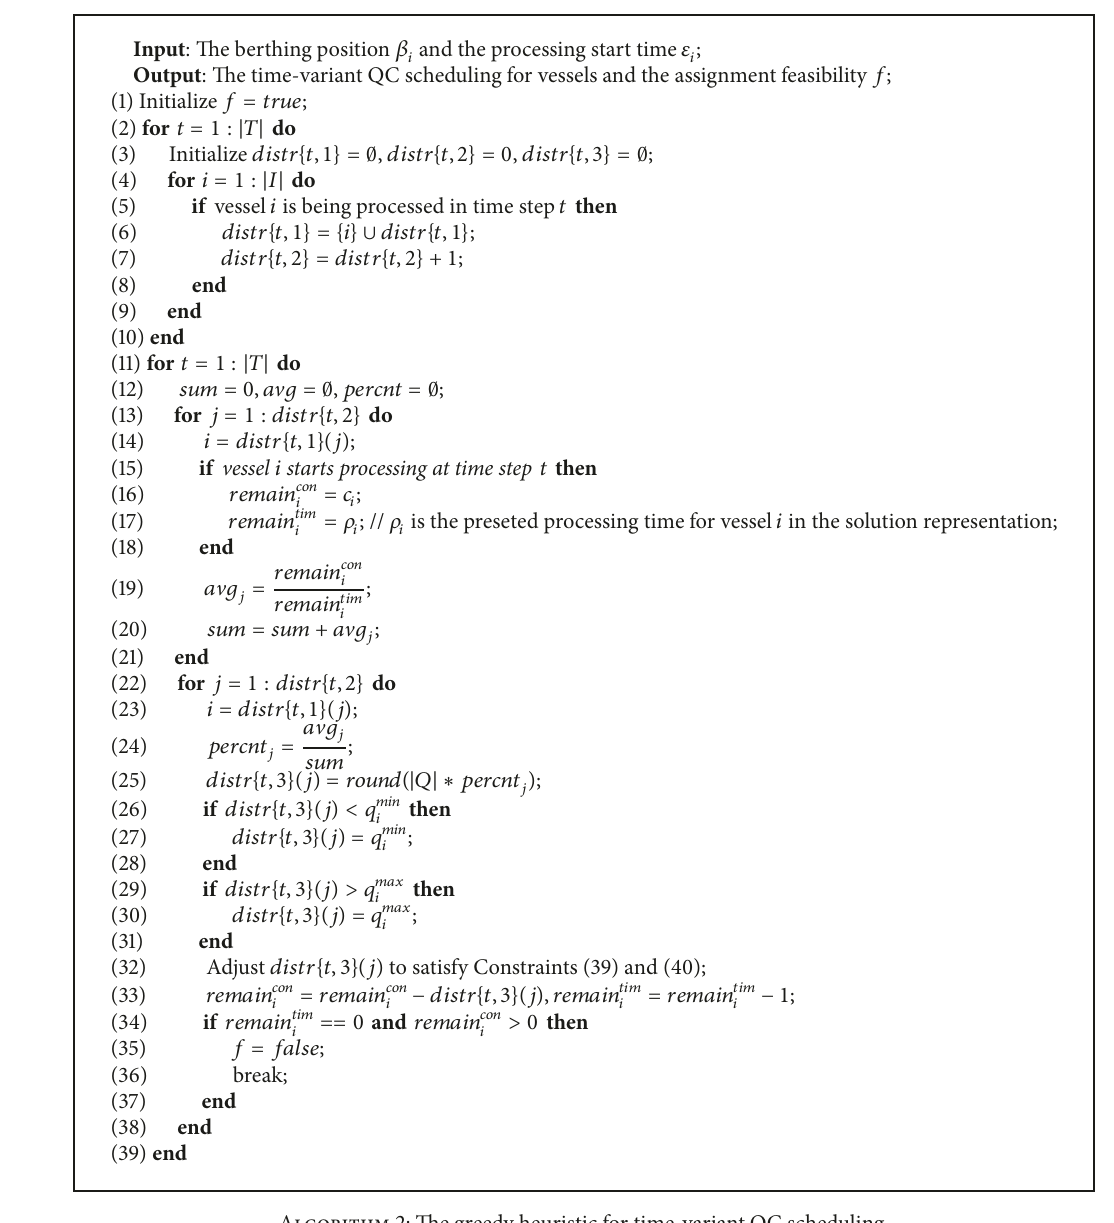
Algorithm 2: The greedy heuristic for time-variant QC